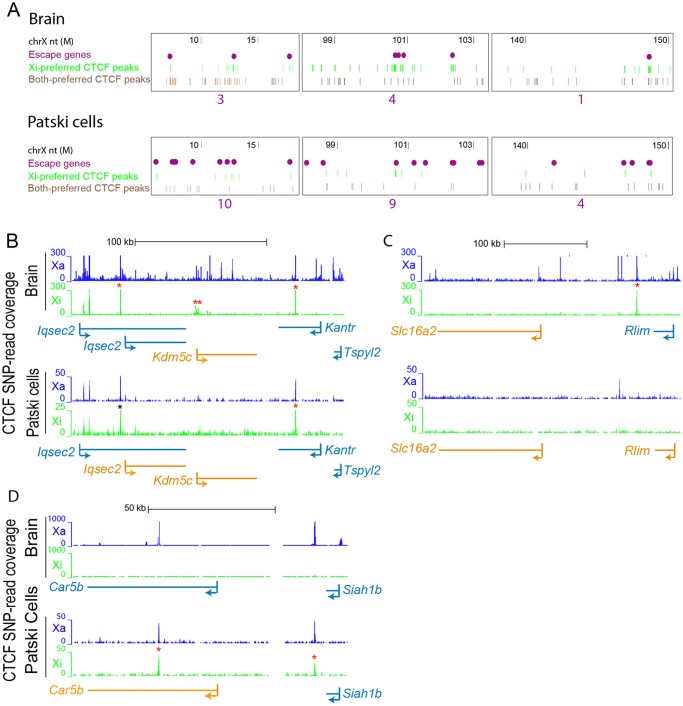
CTCF peaks density and distribution differ in brain and Patski cells.(A) Examples of Xi-preferred and both-preferred CTCF peaks distribution in three X chromosome regions (coordinates in million bp on top). The density of escape genes (purple dots, with total number under each region) is inversely related to the density of Xi-preferred (green) and both-preferred (brown) CTCF-binding peaks when comparing brain to Patski cells. (B) Allele-specific CTCF binding profiles around Kdm5c, a common escape gene flanked by Iqsec2 and Kantr. In brain where only Kdm5c escapes XCI, CTCF binding is present at the 5’ end of the gene at the transition (double star) between Kdm5c and Iqsec2 whose short and long transcripts are subject to XCI (see also S4A Fig). In Patski cells there is no such CTCF binding between Kdm5c and Iqsec2, which escapes XCI. CTCF also binds proximal of the Iqsec2 short transcript in both brain and Patski cells, which could represent a proximal boundary of an escape domain. (C) Similar analysis at a region around Rlim, a gene that escapes XCI in Patski cells but not in brain, while the adjacent gene Slc16a2 escapes XCI in both systems. A CTCF peak is present in the transition region only in brain. (D) Similar analysis in a region around Car5b, a gene that escapes XCI in Patski cells but not in brain (see also S4B Fig). CTCF binding peaks are located within the body of Car5b and in the transition between Car5b and Siah1b on the Xi in Patski cells. Genes that escape XCI are labeled orange and genes subject to XCI blue. Xa SNP reads are in blue and Xi SNP reads in green. Red stars indicate Xi- or both-preferred CTCF peaks on the Xi; one of the CTCF peaks is marked by a black star because it is present but was not called preferred at our cutoff.